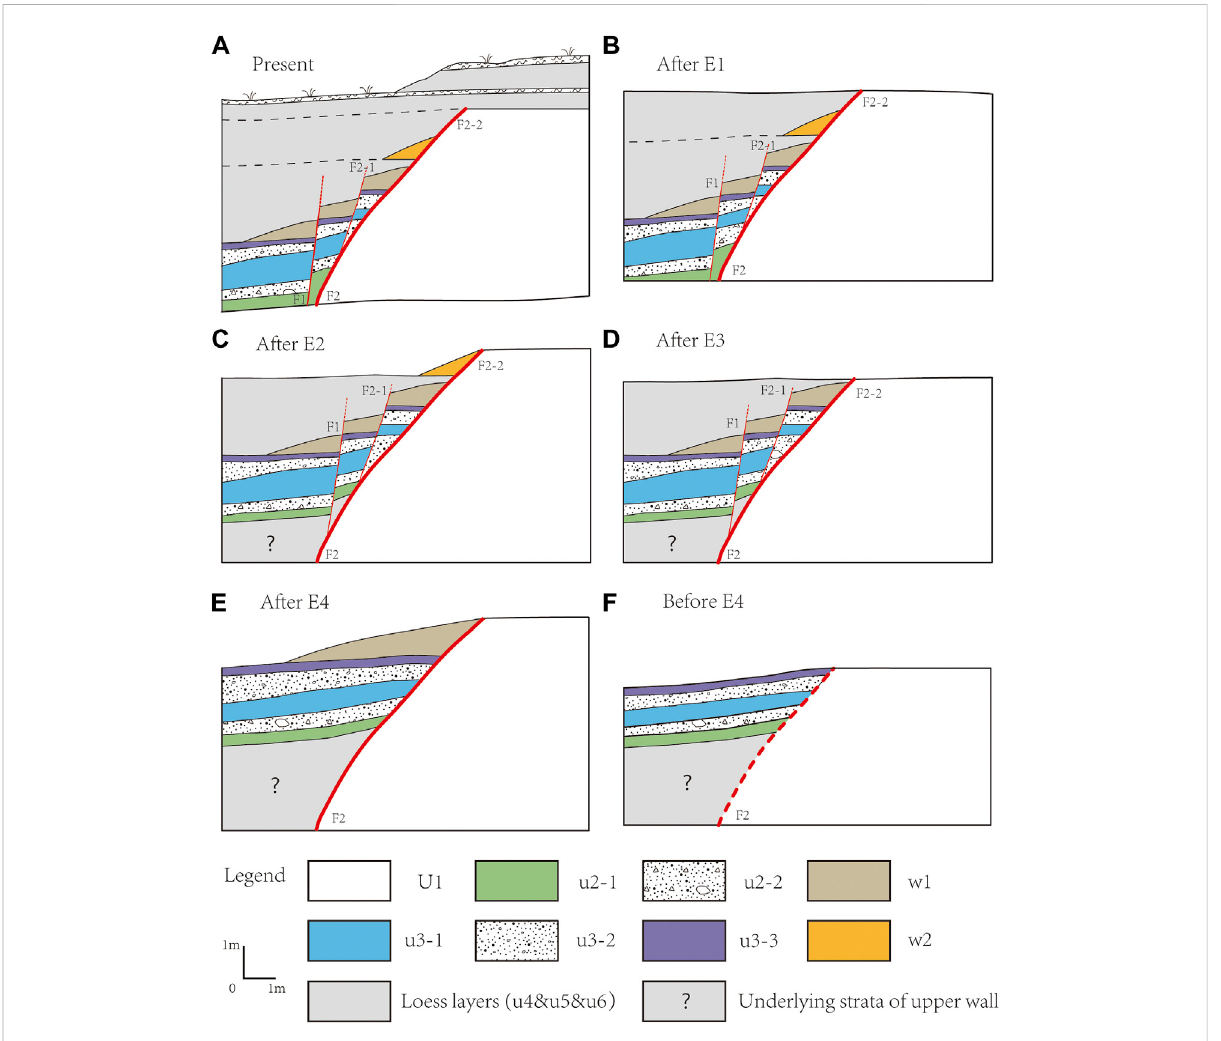
FIGURE 11 Possible restoration of the stratigraphy of the Xujiabao pro fi le, showing the deformation associated with events E1 to E4. (A) Present-day situation; (B) colluvialwedgew2andthebottomofU5wasoffset,sotherewasatleastoneeventafterE2,andtheupperbreakpointwasnotclear; (C) E2occurredafterthedepositionofU4strata.ThemainfaultF2(F2-2)wasactive,andthecolluvialwedgew2wasaccumulated; (D) E3occurredafter the deposition of U4, the secondary fault F2-1 and F1 were simultaneously active, the U4 and the colluvial wedge w1 accumulated in the E4 event were offset by this event and divided into w1-1, w1-2, and w1-3; (E) E4 occurred after the deposition of u3-3, and the colluvial wedge W1 formed; and (F) possible original situation before